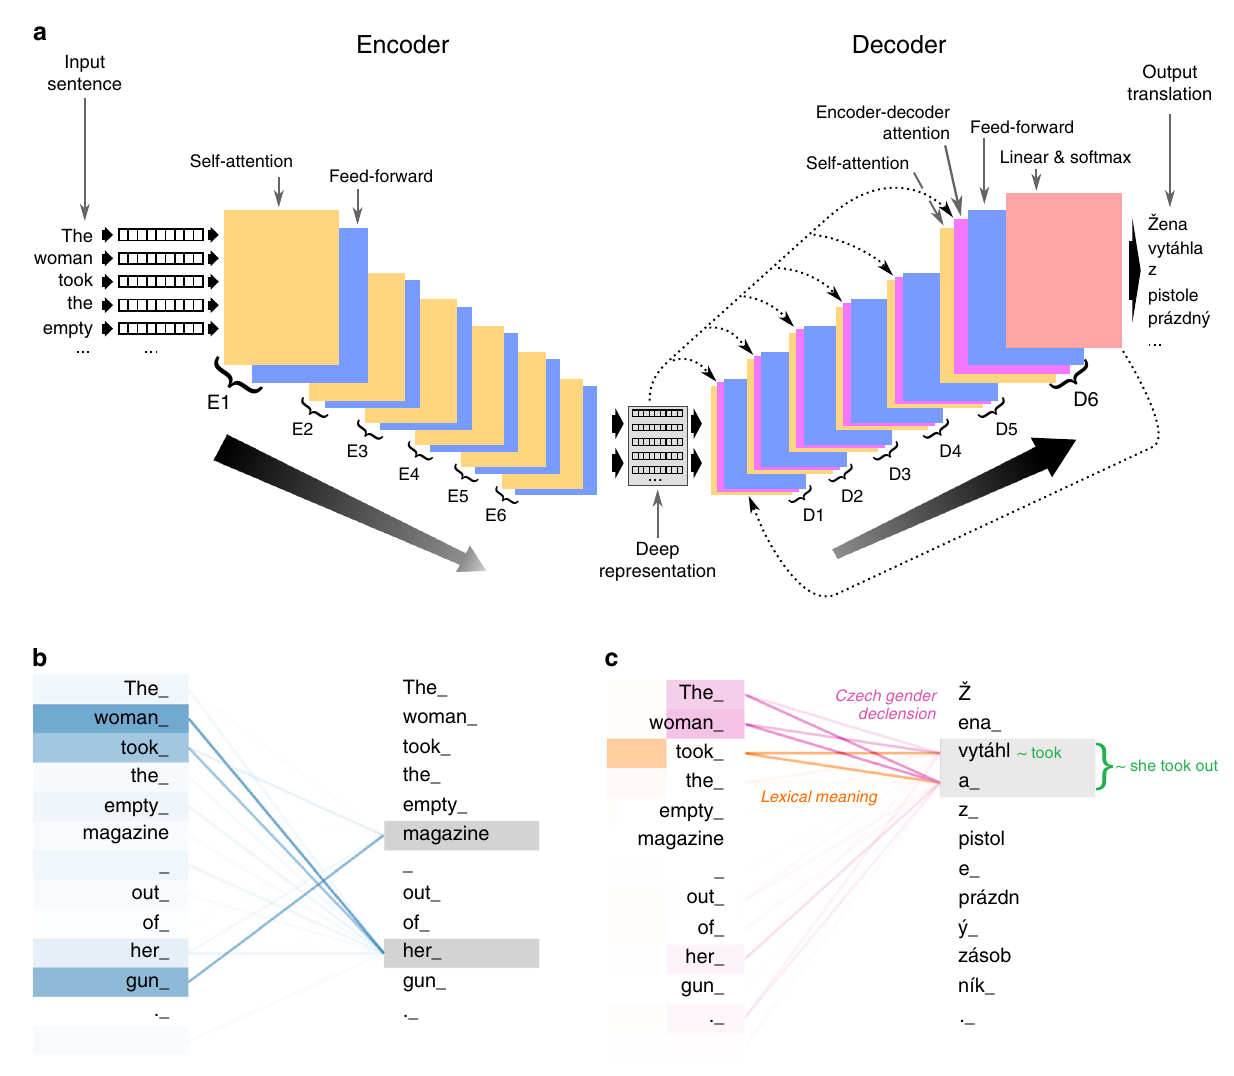
Fig. 1 Model architecture of the CUBBITT machine translation system. a The input sentence is converted to a numerical representation and encoded into a deep representation by a six-layer encoder, which is subsequently decoded by a six-layer decoder into the translation in the target language. Layers of the encoder and decoder consist of self-attention and feed-forward layers and the decoder also contains an encoder-decoder attention layer, with an input of the deep representation created by the last layer of encoder. b Visualization of encoder self-attention between the fi rst two layers (one attention head shown, focusing on “ magazine ” and “ her ” ). The strong attention link between ‘ magazine ’ and ‘ gun ’ suggests why CUBBITT ultimately correctly translates “ magazine ” as “ zásobník ” (gun magazine), rather than “ č asopis ” (e.g., news magazine). The attention link between ‘ woman ’ and ‘ her ’ illustrates how the system internally learns coreference. c Encoder-decoder attention on the second layer of the decoder. Two heads are shown in different colors, each focusing on a different translation aspect which is described in italic. We note that the attention weights were learned spontaneously by the network, not inputted a